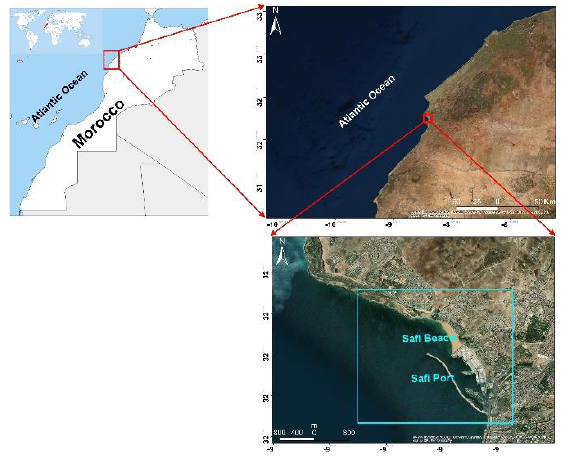
Figure 1. Location of the study area